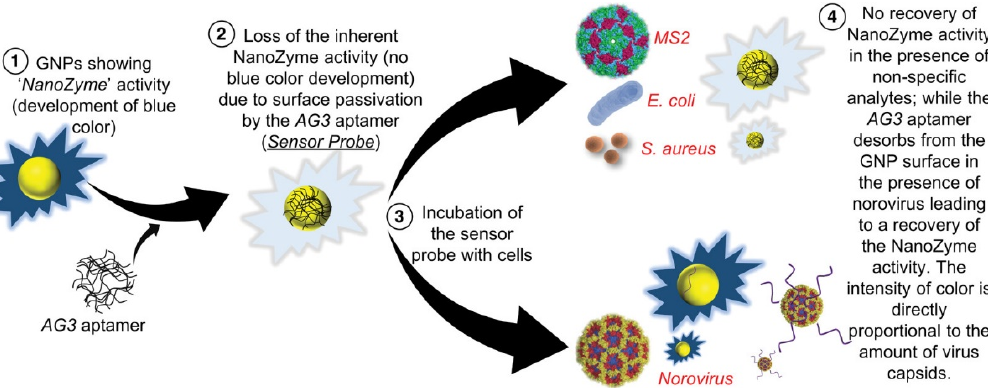
Figure 21. Steps involved in the determination of norovirus using an Apt–Au nanozyme. Reprinted with permission from [68]. Copyright © 2019 American Chemical Society.